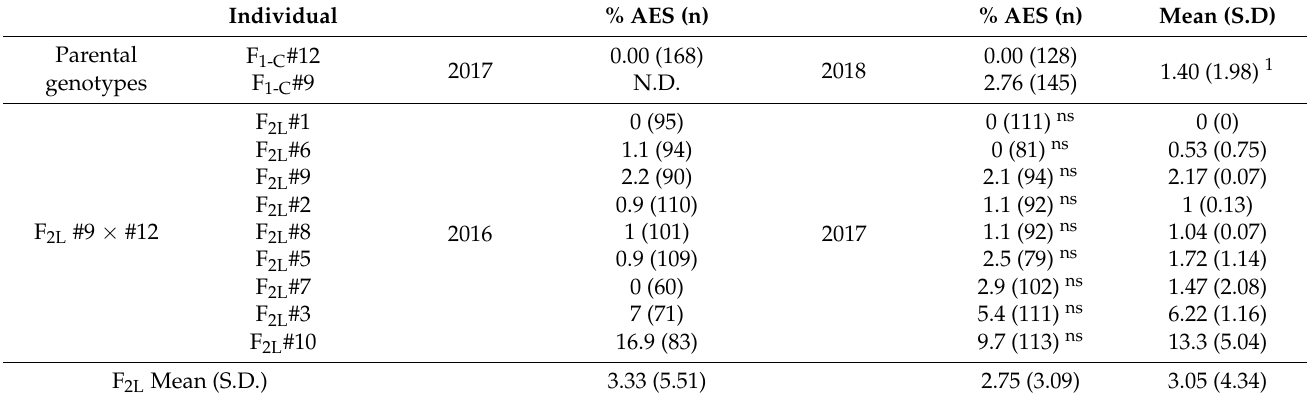
Table 4. Apospory expressivity of parental genotypes and F 2L (#9 × #12)